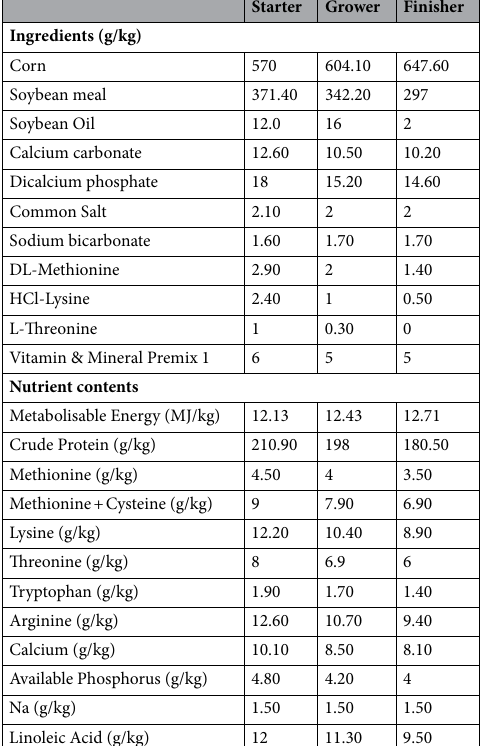
Table 1. Ingredients and nutrient contents of basal diets in different experimental periods. 1 The premix is included A: 10,000 IU, D 3 : 5000, E: 50 IU, K: 3 mg, B 1 : 2 mg, B2: 6 mg, Niacin: 60 mg, Pantothenic Acid: 15 mg, B 6 : 3 mg, Biotin: 0.10 mg, Folic Acid: 1.75 mg, B 12 : 0.016; Cu: 16 mg, I: 1.26, Fe: 40 mg, Mn: 120 mg, Se: 0.30 mg, Zn: 100